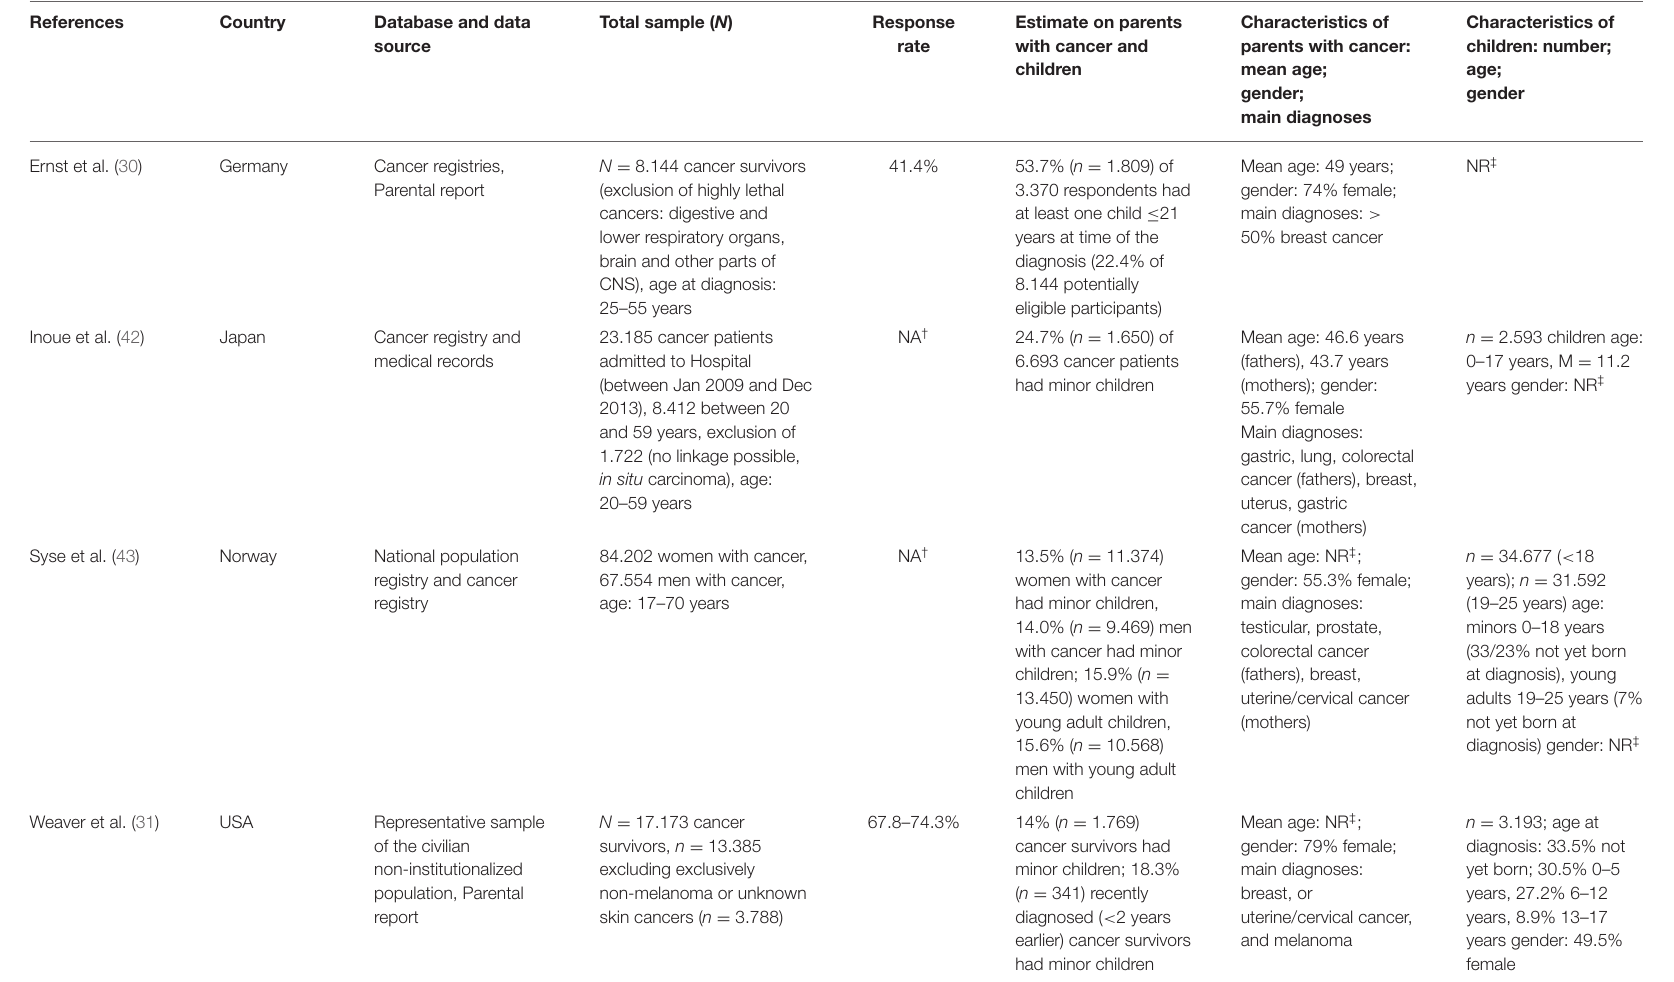
TABLE 1 | Study characteristics and estimates of parents affected with cancer from n = 5